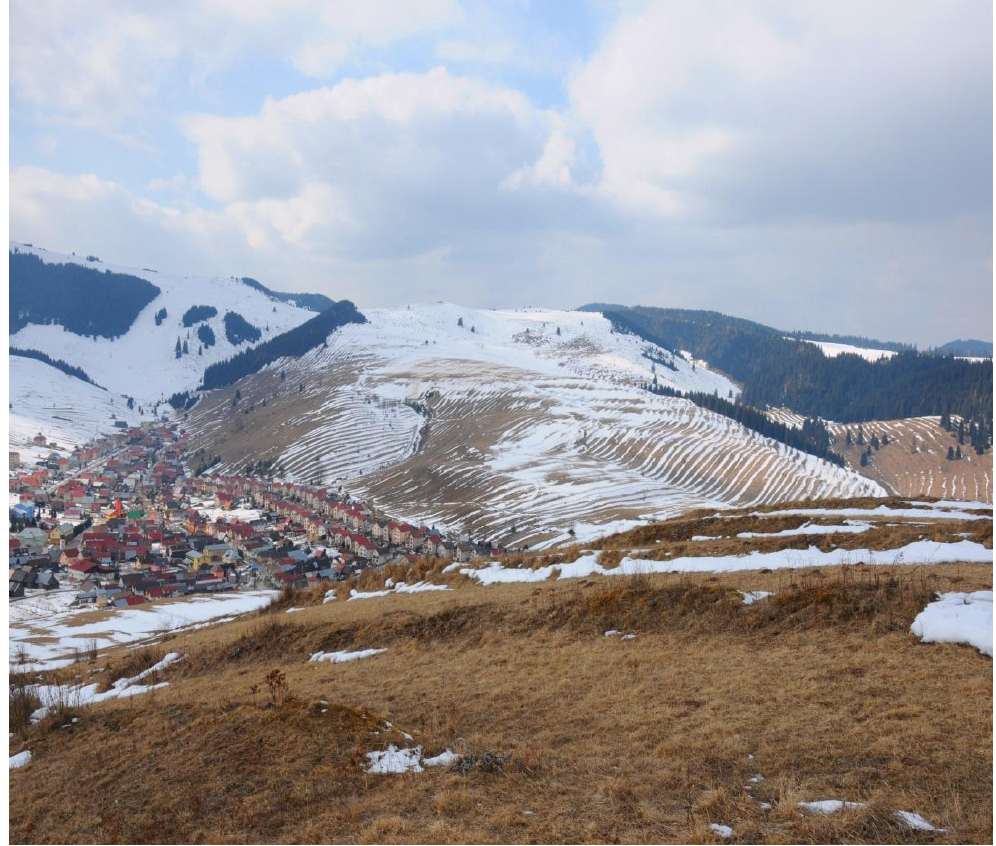
Figure 1. The traditional way of using the agrarian landscape with narrow-strip fields and plots, with the orientation of the ramparts in the direction of the slopes, photographed at the end of the winter season. Source: J. Hreško, 6.3. 2010.